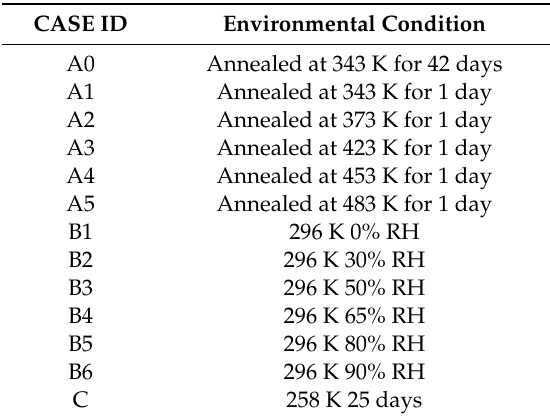
Table 2. A highlight of the